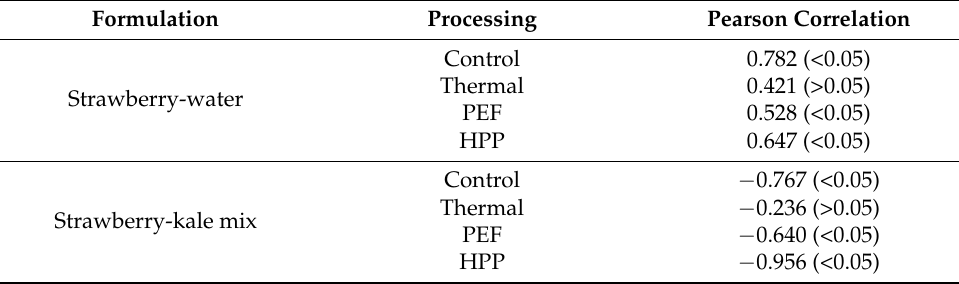
Table 6. Correlation between color a* and the total anthocyanin content during